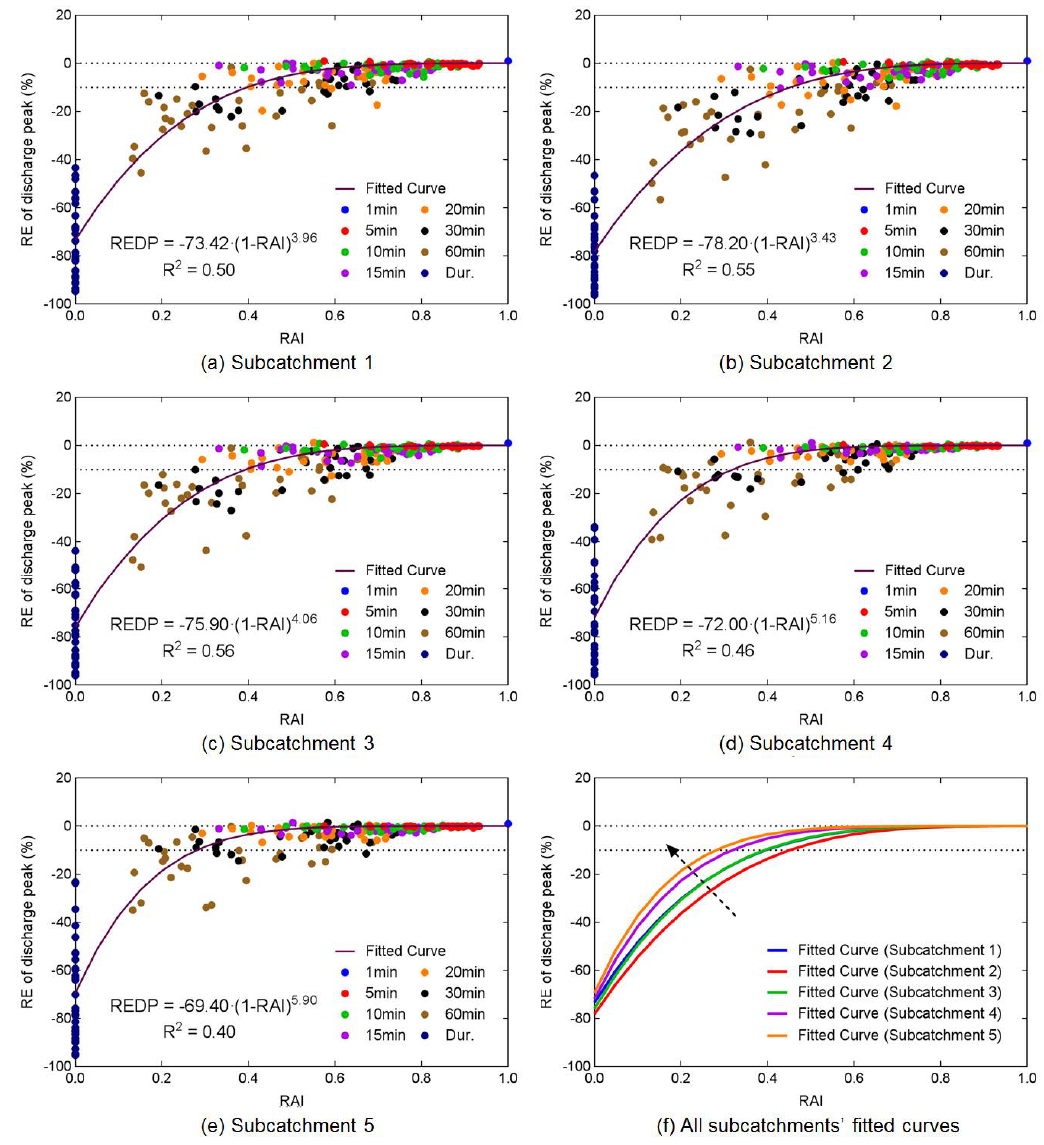
Figure 9. Relationship between the effect of TRR and the characteristics of rainfall and underlying surfaces. ( a – e ) show the relationship for Subcatchment 1 to Subcatchment 5, respectively, and ( f ) shows all subcatchments’ fitted curves.